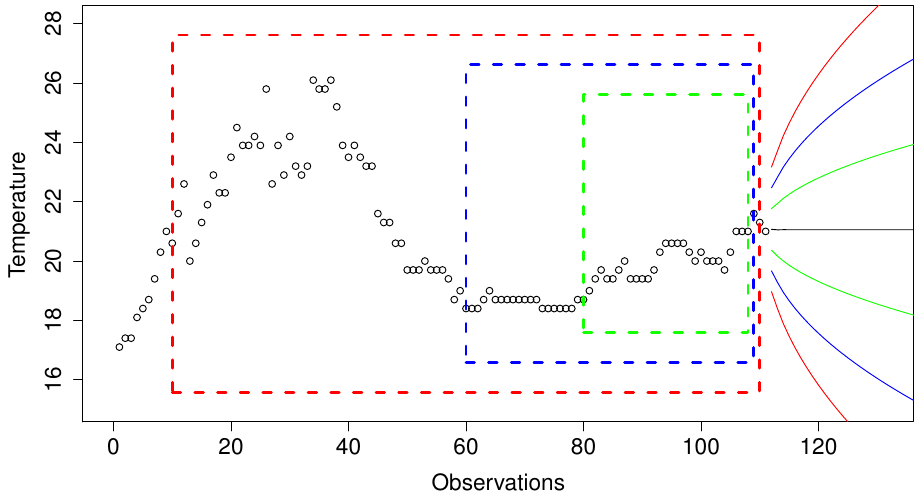
Figure 8. Example of data-window sizes and the standard errors allowed for classifying the next observation. Dotted red, blue, and green lines represent a data-window size of 100, 50, and 30 values respectively. The solid red, blue, and green lines mark 3, 2, and 1 times the standard error respectively.